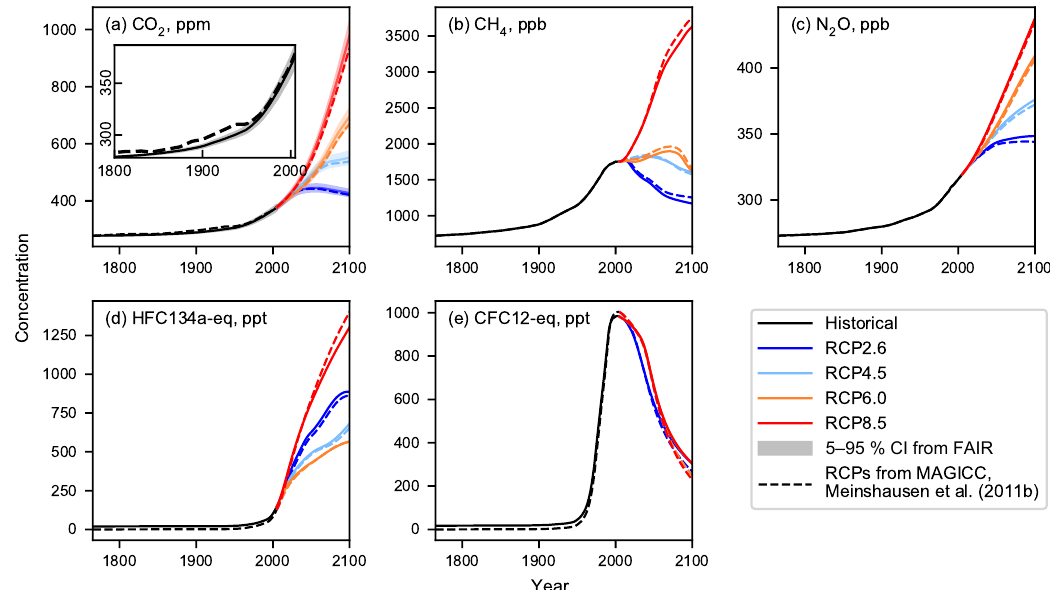
Figure 4. Comparison of the historical and RCP greenhouse gas concentrations in FAIR (heavy solid lines) with 5–95% confidence intervals (shading) for CO 2 . Dashed lines show the concentrations from MAGICC6 (Meinshausen et al., 2011b). For CFC12-eq, the RCP4.5 and RCP6.0 lines lie underneath the RCP8.5